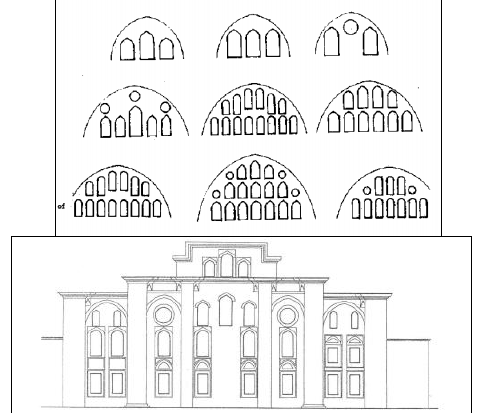
Figure 4. Window groupings within the shape of arch in Sinan’s mosques and South East façade plans layout of Şehzade (Erzen J. N.,